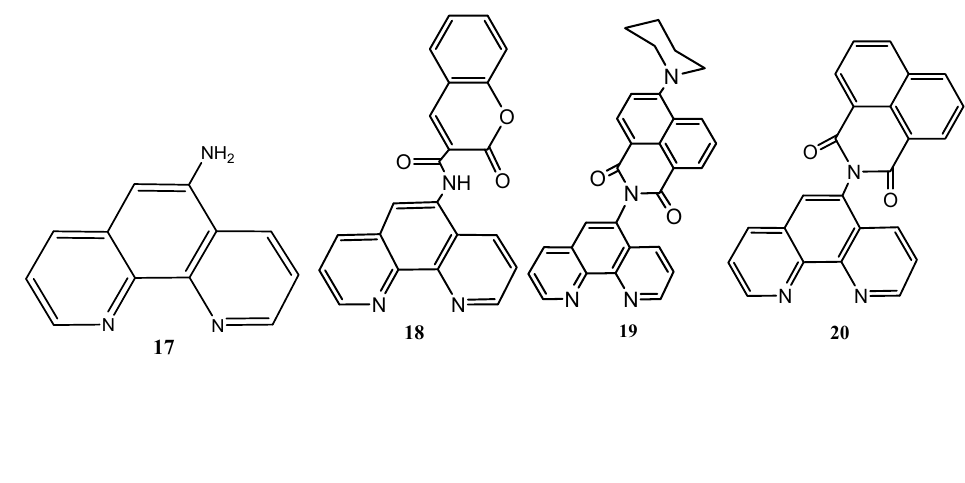
Figure 13. Molecular structures of 5-position functionalized phenanthroline